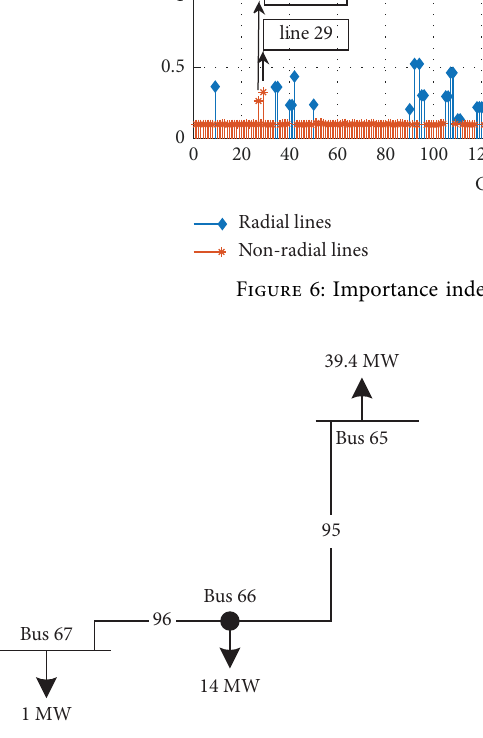
Figure 7: Te position of lines 95 and 96 in the network. Figure